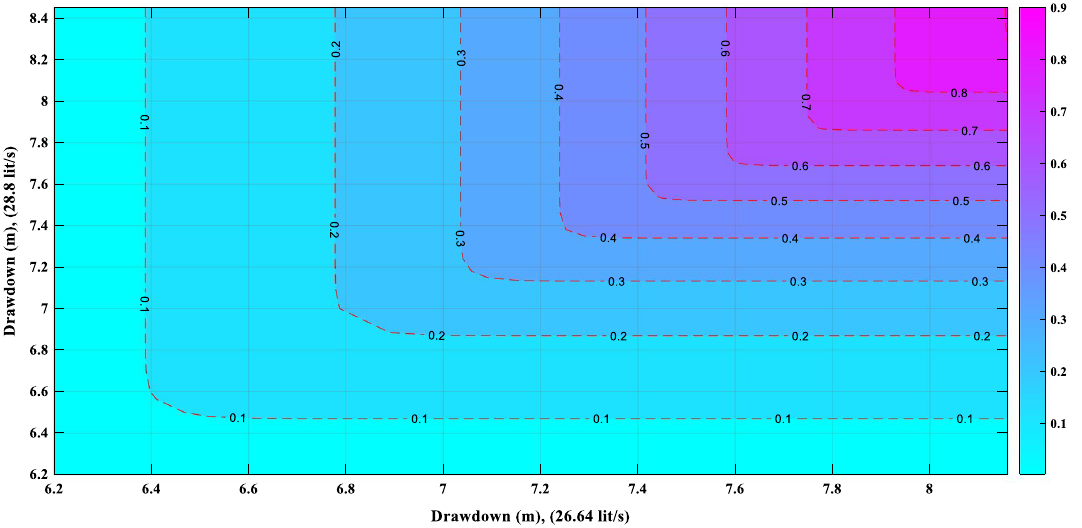
Fig. 11 Results of joint cumulative frequency analysis regarding the groundwater drawdown with a constant pumping of 28.8 L per second, given by pumping with a constant discharge of 26.64 L per